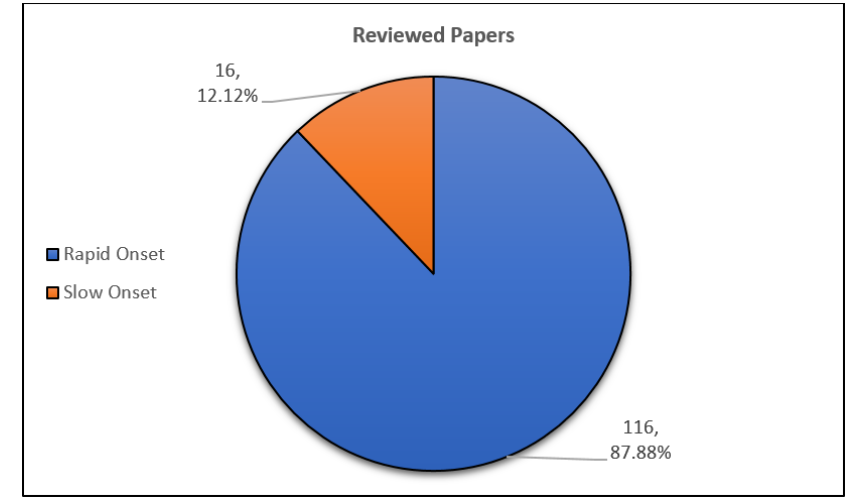
Figure 11. Breakdown of Reviewed Papers based on Disaster